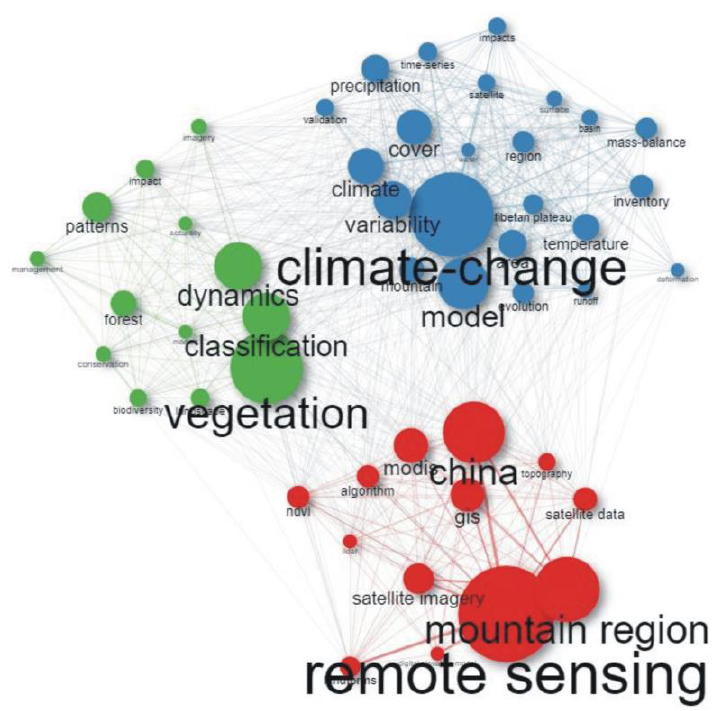
Figure 5. Co-occurrence network for the keywords used in this study. Each node represents a keyword, the size of the node shows the number of occurrences of the keyword, and the thickness of the line shows the degree of connection.